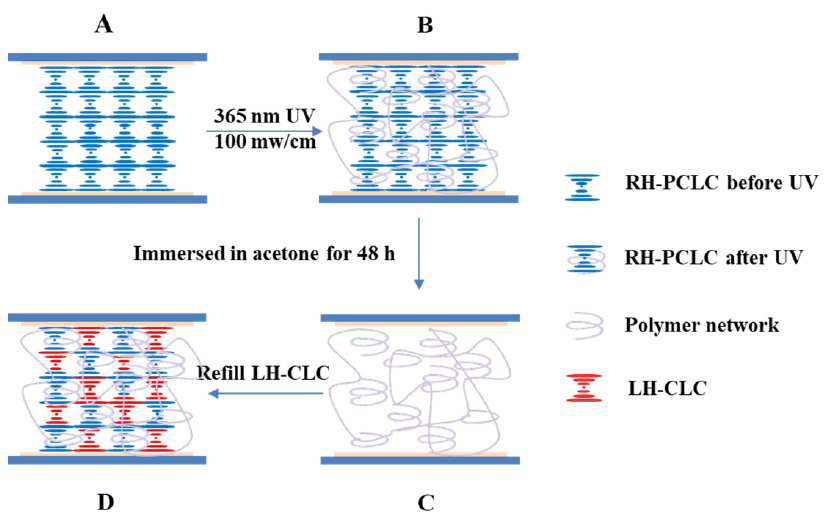
Figure 1. A schematic diagram of the preparation of the superstructure. ( A ) RH-PCLC before UV exposure (Sample A), ( B ) RH-PCLC after UV exposure (Sample B), ( C ) pure polymer network (Sample C), ( D ) polymer network refilled with the LH-CLC (Sample D). The RH-PCLC mixture was filled into the cell in its isotropic phase (85 ◦ C) with the help of capillary force. To obtain a uniform standing helix alignment (Grandjean texture), the sample was slowly cooled down from the isotropic phase to the cholesteric